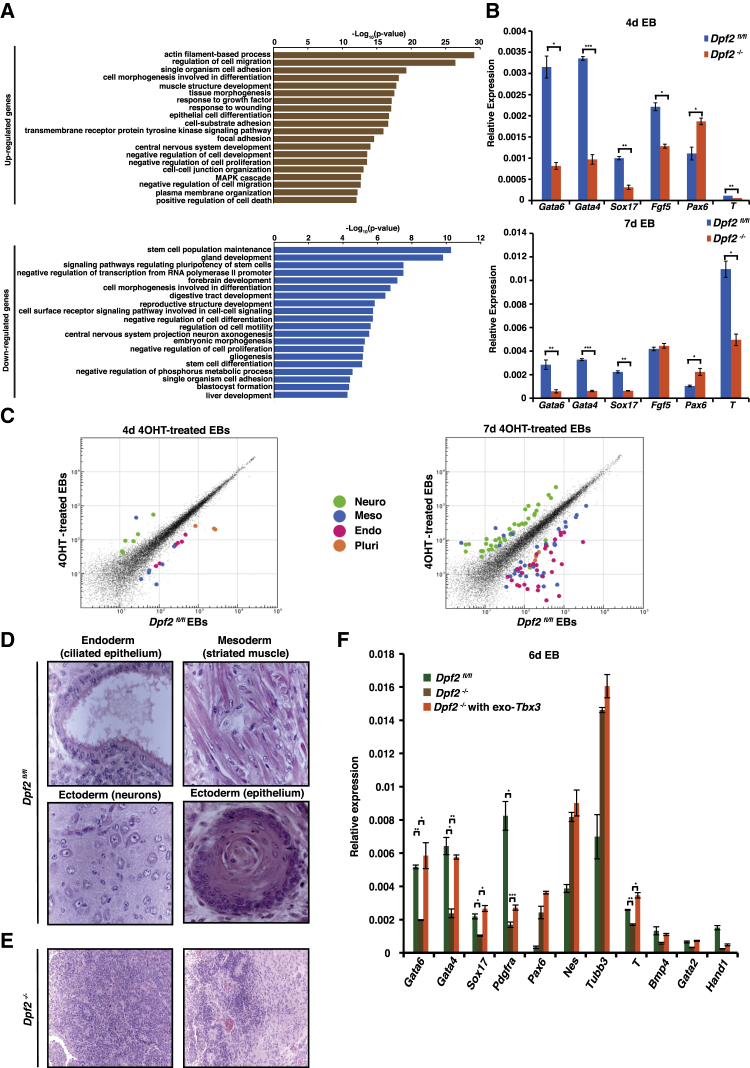
Dpf2 Deletion Impairs ESC Differentiation(A) GO analysis for biological processes associated with genes differentially expressed upon Dpf2 deletion in ESCs.(B) qPCR analysis for transcript levels of the indicated lineage-specific genes on days 4 and 7 of EB differentiation of Dpf2fl/fl and Dpf2−/− cells.(C) Global gene expression profiles of Dpf2fl/fl and Dpf2−/− EBs. Neuro, neural ectoderm markers; Meso, mesoderm markers; Endo, endoderm markers; Pluri, pluripotency-associated genes.(D) Images of H&E-stained teratomas from Dpf2fl/fl ESCs. Magnification, 630×.(E) As in (D), except for Dpf2−/− ESCs. Magnification, 200×.(F) qPCR analysis for transcript levels of the indicated lineage-specific genes in day 6 EBs from Dpf2fl/fl, Dpf2−/−, and Dpf2−/− with ectopically (exo) expressed Tbx3.